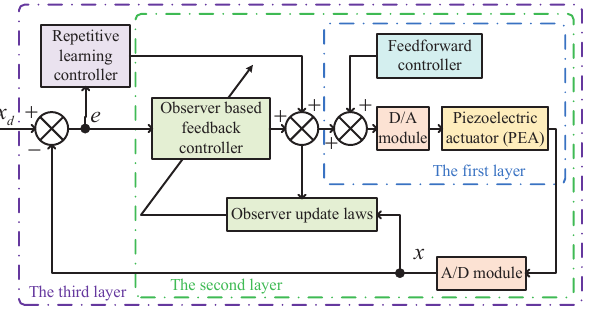
Figure 5. Control system